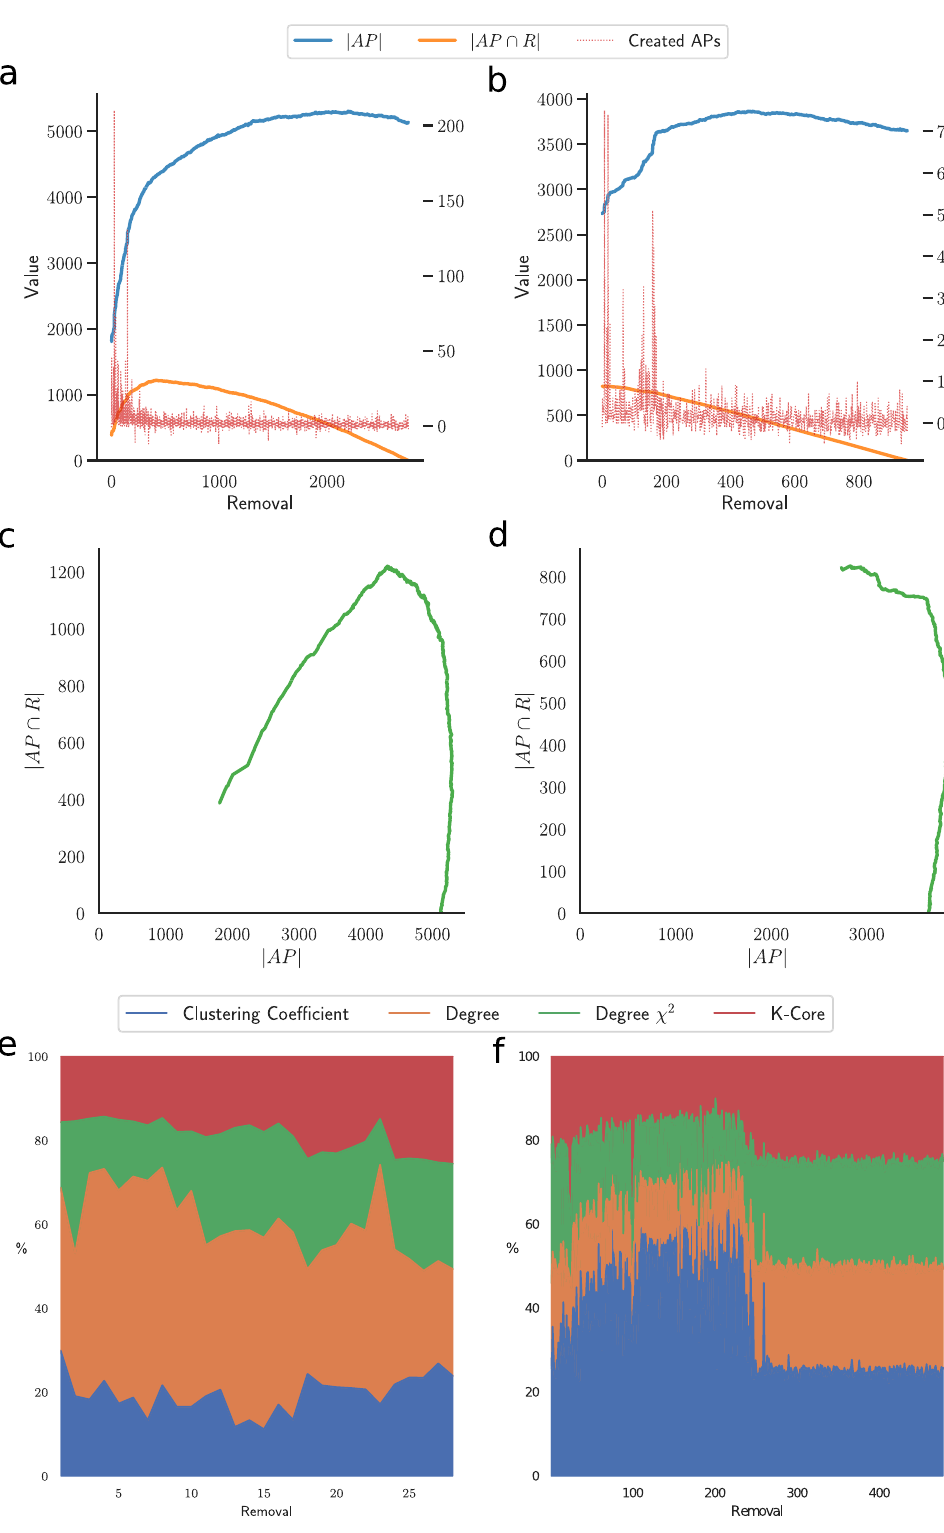
Fig. 6 Understanding our models. The analysis of the Articulation Points of the networks ( AP ) and how many of them are in the removal list ( R ) shows that the models are learning a long-term strategy that aims to create new articulation points and remove the ones that deal most damage to the network. As an example, we show the linux ( a , c ) and the internet-topology ( b , d ) networks. This is achieved using the input node features discussed above, that allow the identi fi cation of clusters and bridges. We show an example of the relative importance of the node features for the corruption ( e ) and for the subelj-jdk ( f )